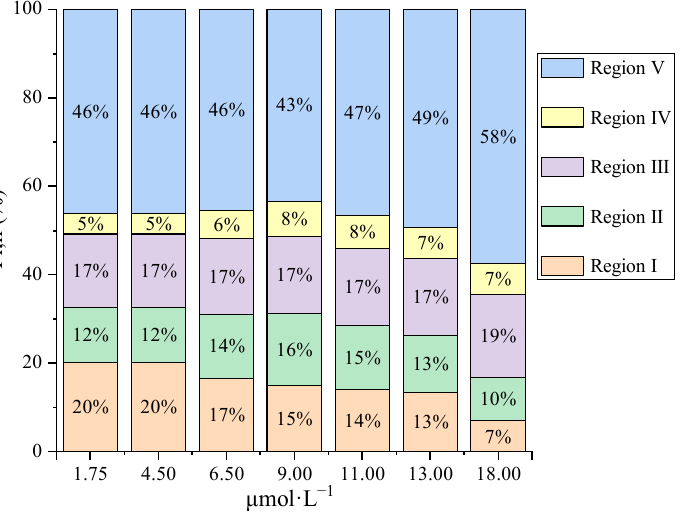
Figure 3. The percentage of contribution of different regions in Δ EEM for bulk PPFA with different iron concentrations.